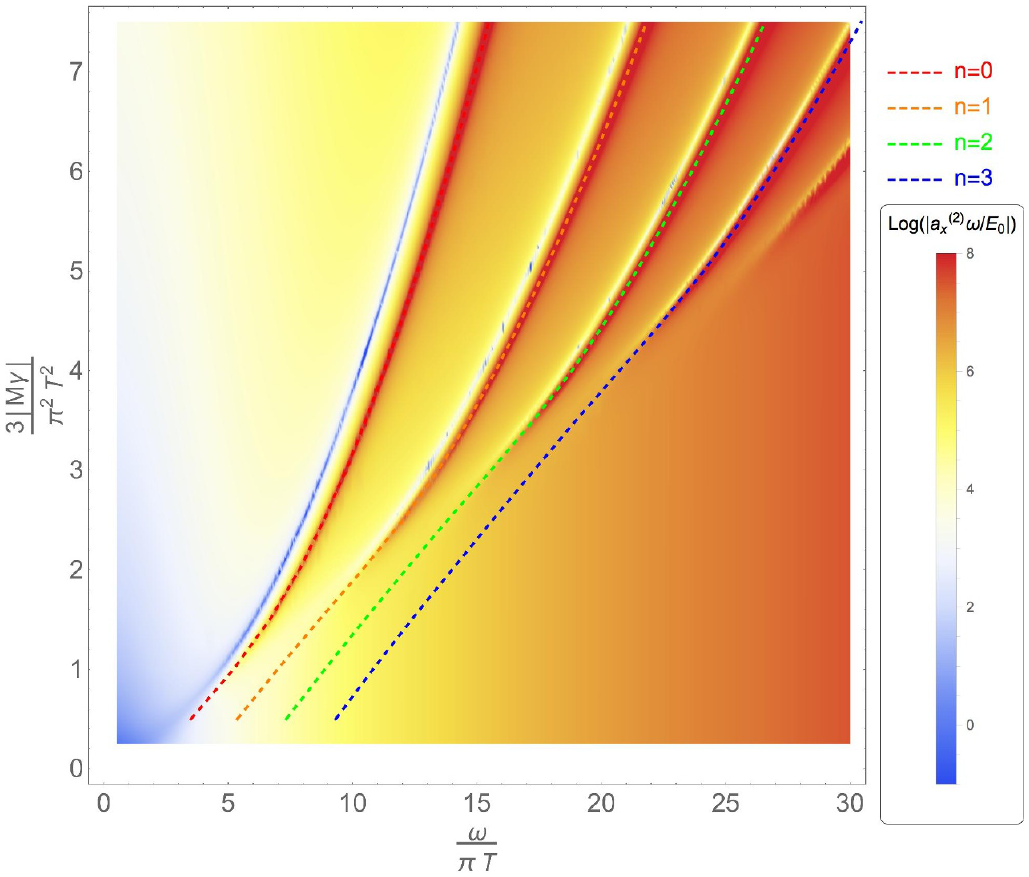
Figure 4 . A density plot exhibiting the absolute value of a (2) x (representative of the expectation value of J x , cf., (2.15)) as a function of magnetic (cid:12)eld M and driving frequency ! for a periodic driving force. The real part of the four lowest quasi normal modes are represented by dashed lines whose coloring matches those of (cid:12)gure 3. Once the imaginary part of the quasi normal mode becomes su(cid:14)ciently small (or, the temperature becomes su(cid:14)ciently small) and the driving frequency matches the real part of the quasi normal mode, then a sharp increase in the response of the current is observed. Curiously, a sharp decrease in the amplitude seems to always precede